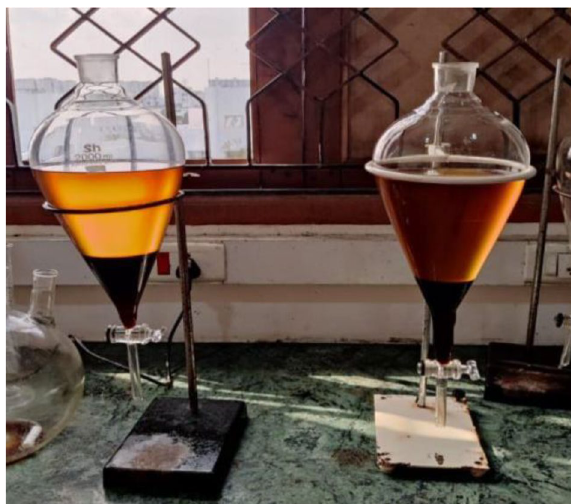
Figure 1. Preparation of